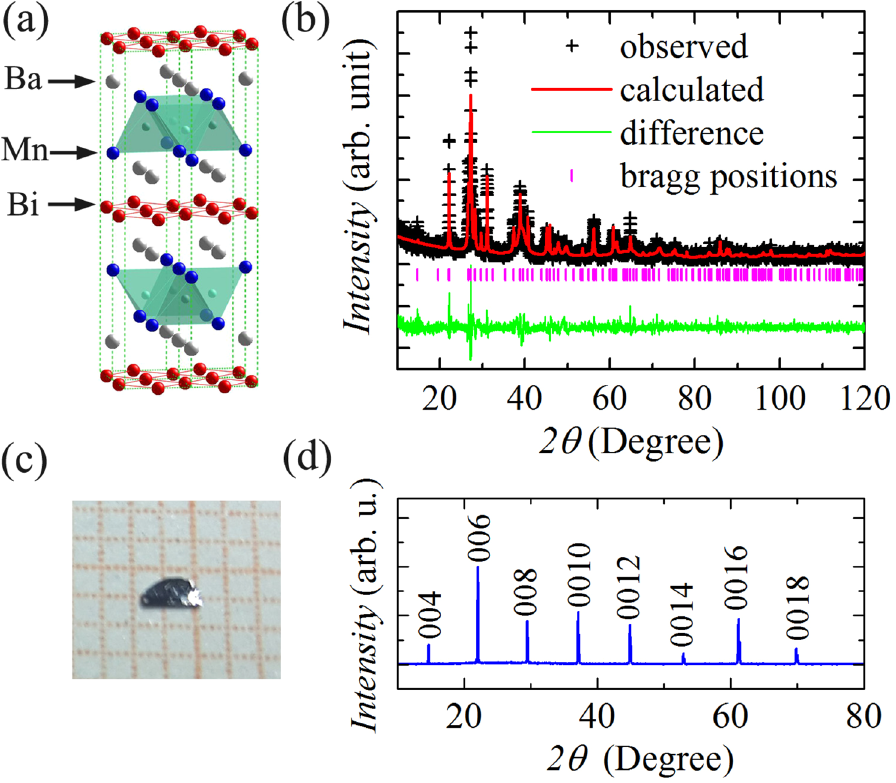
Figure 1. ( a ) Crystal structure of BaMnBi 2 . ( b ) XRD pattern of powder obtained by grinding BaMnBi 2 crystals. Its Rietveld refinement is shown by the solid lines. ( c ) A photo of BaMnBi 2 crystal. ( d ) Single-crystal XRD pattern of BaMnBi 2